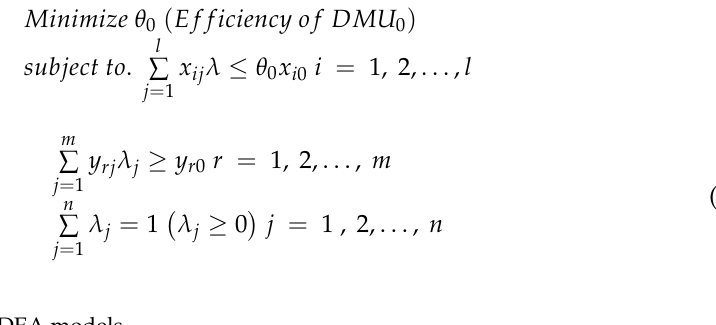
Table 2. Comparison of DEA models.